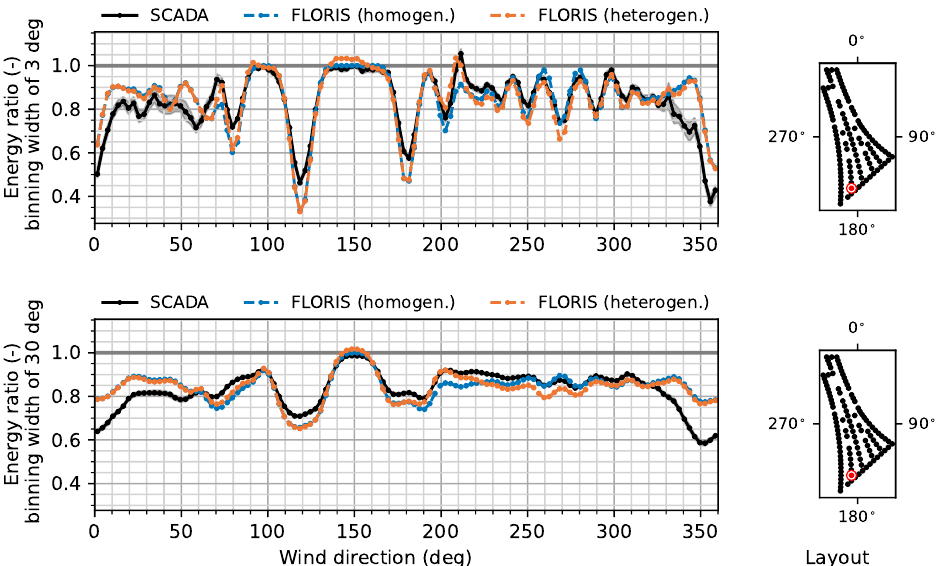
Figure 8. Energy ratio curves for Turbine 32 in the Anholt wind farm, in which the reference turbines are the five closest upstream turbines, and the reference wind direction is the average of the wind direction measurements of neighboring Turbines 30, 31, 33, and 42. The shaded regions represent 90% confidence interval bounds obtained through bootstrapping. The layout schematic on the right shows the location of Turbine 32 in the wind farm.